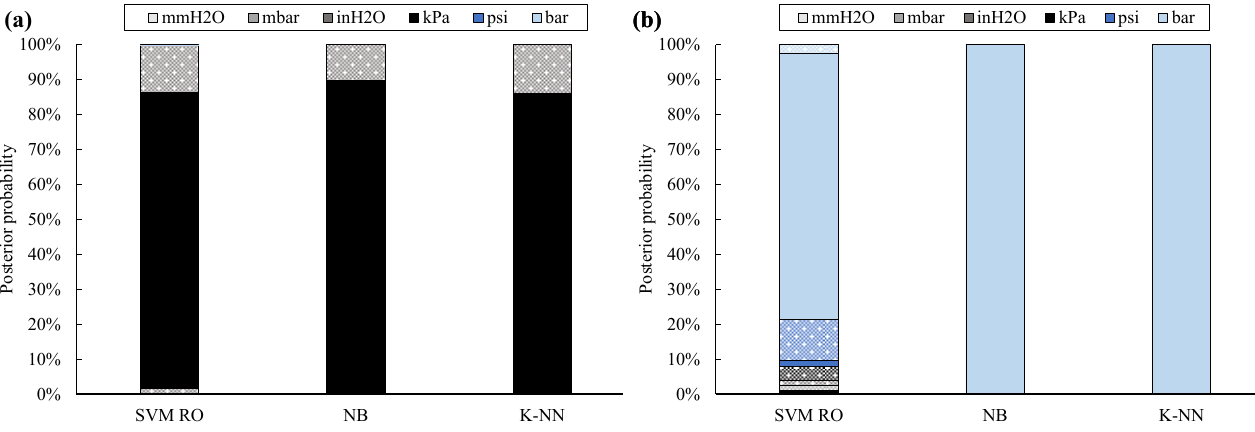
Figure 5. Posterior probability for twelve UOMs: site cross-validation by means of filtered data (full bar: absolute UOMs, dotted bar: gauge UOMs; kPa absolute sites ( a ), bar absolute site ( b )).